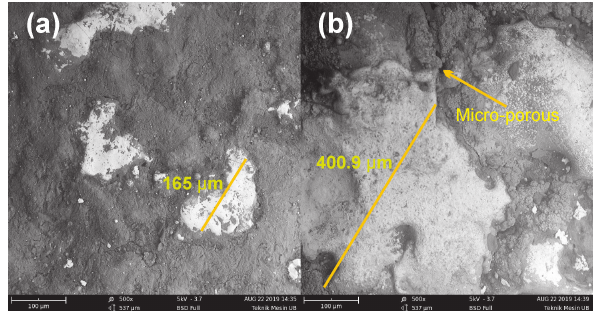
Figure 3: SEM images of BMG machined surface at (a) 4 A, 50 µ s combination and (a) 12 A, 150 µ s combination using 500 times magnification